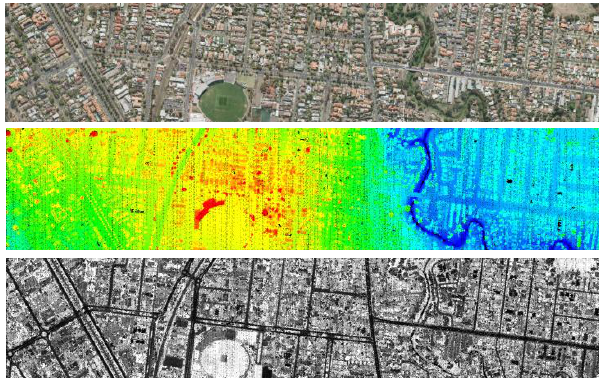
Figure 4. Orthoimage (top), LiDAR DSM (middle)and LiDAR intensity image(bottom)